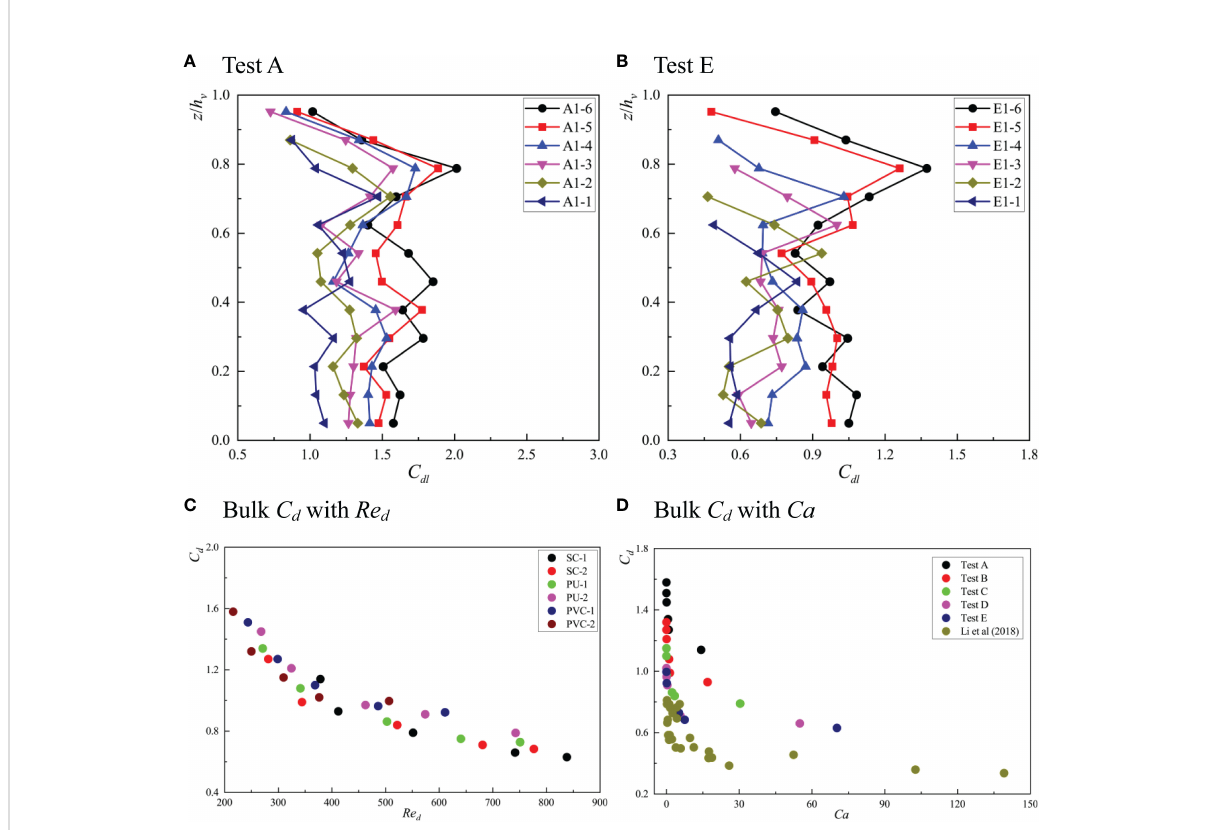
FIGURE 5 The vertical distribution of local drag coef fi cient, C dl under (A) Test A and (B) Test E and the relationship between C d and Re d (C) and between C d and Ca (D)